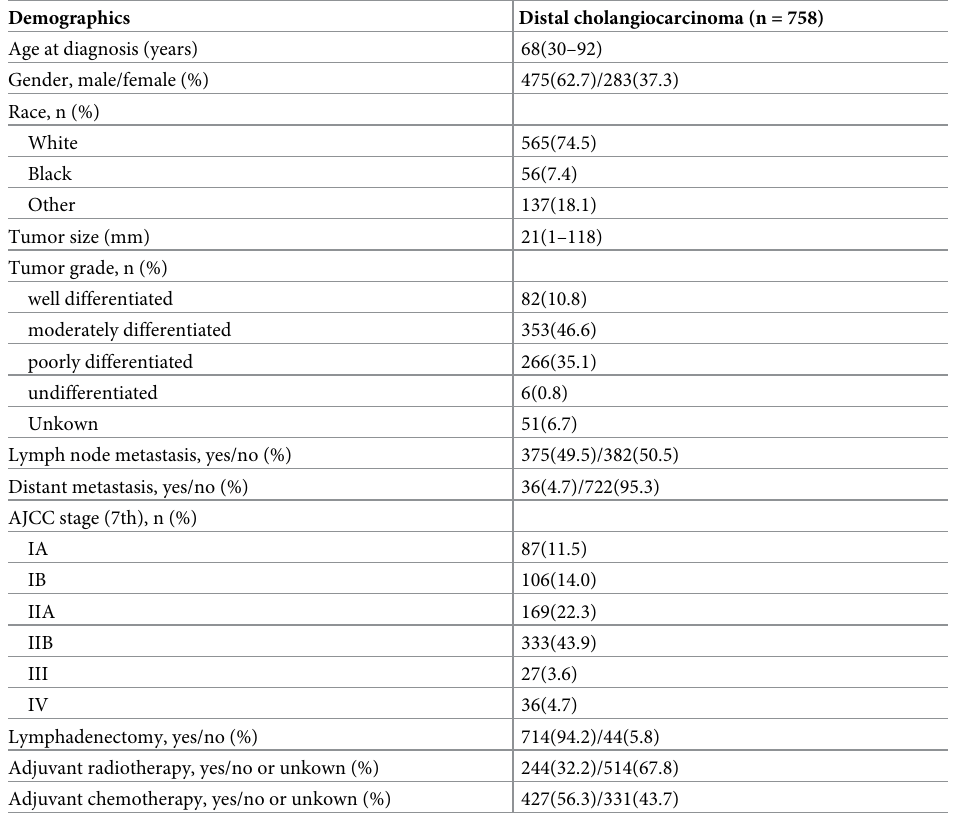
Table 1. Demographics and clinical characteristics in the entire cohort (n =